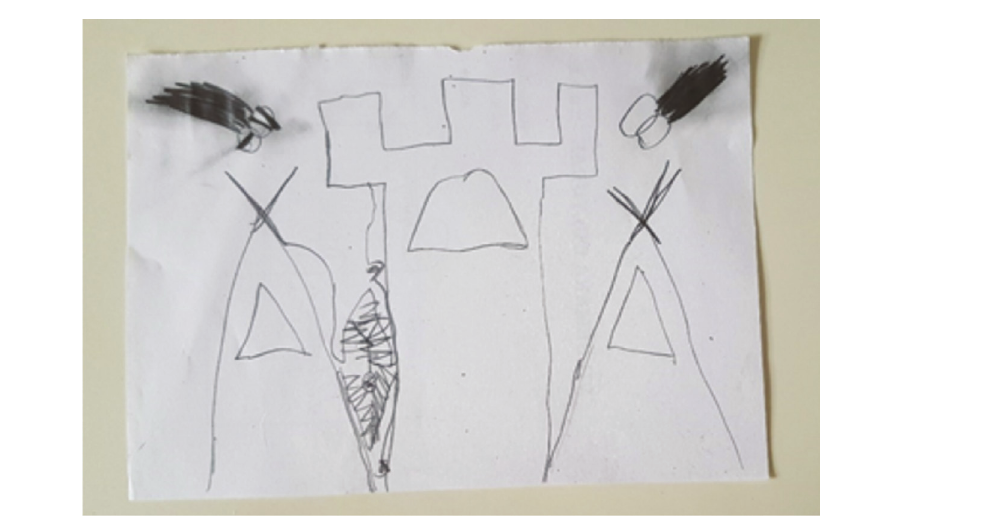
Figure 2: Drawing of a refugee camp made a pupil (Photograph: Author,